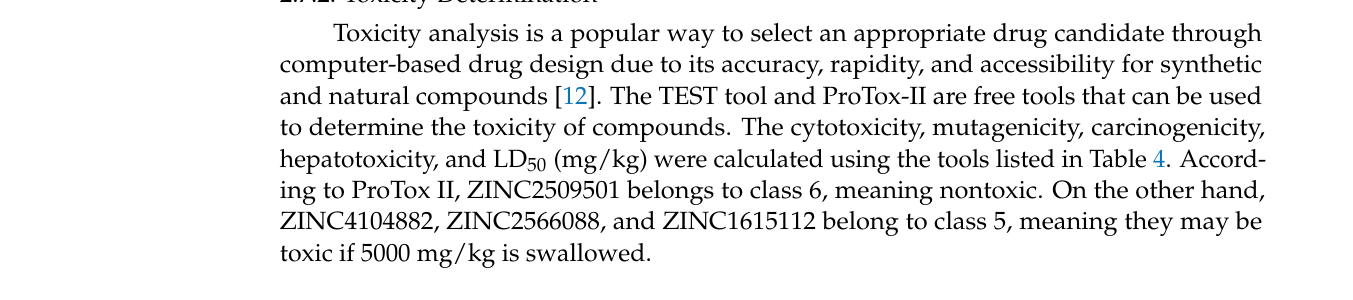
Table 4. Analysis of several aspects of toxicity (organ toxicity, toxicity class, Tox21-nuclear-receptor signaling pathways, Tox21-stress-response pathway, fathead minnow LC 50 (96-h), developmental toxicity, water solubility, oral rat LD 50 , and bioaccumulation factor) of the four selected